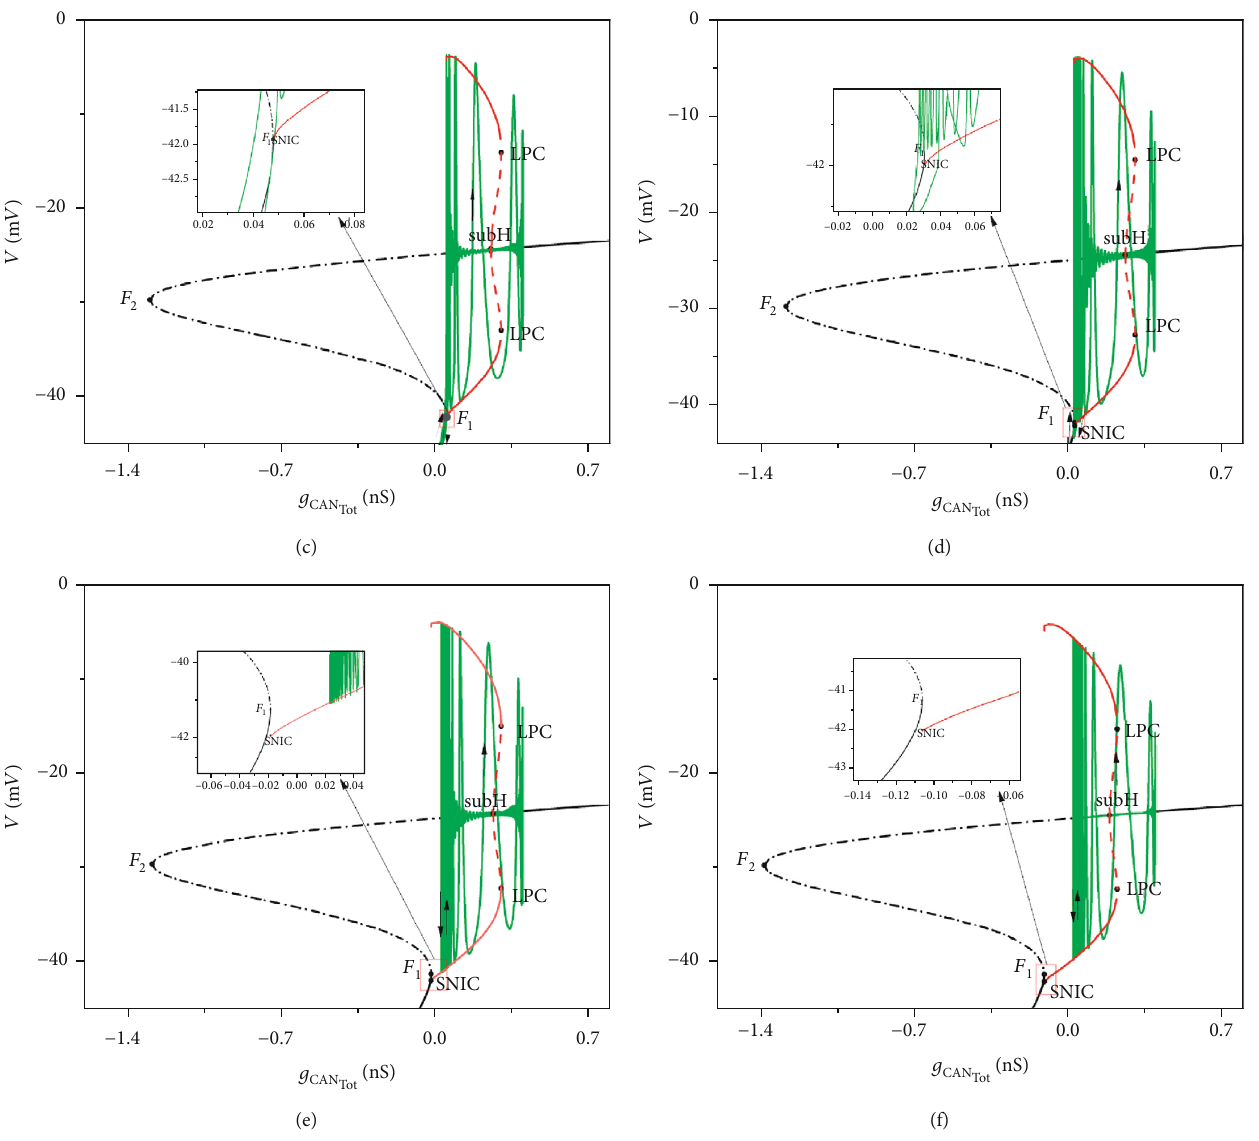
Figure 5: Fast-slow bifurcation analysis of neuronal fi ring patterns under di ff erent electric currents: (a) I = − 2 μ A/cm 2 ; (b) I = 5 μ A/ extz extz cm 2 ; (c) I = 25 μ A/cm 2 ; (d) I = 30 μ A/cm 2 ; (e) I = 40 μ A/cm 2 ; (f) I = 50 μ A/cm 2 . The black solid line represents the stable extz extz extz extz nodes (lower branch) and stable focus (upper branch); the black dash-dot line represents the saddles (middle branch) and the unstable focus (upper branch); the red dashed and solid lines represent the maximum and minimum values of the unstable and stable limit cycles, ð i = 1, 2 Þ and subH represent the fold bifurcation and Hopf bifurcation of equilibrium; the points LPC, HC, and respectively. The points F i SNIC represent the fold bifurcation of the limit cycle, the homoclinic bifurcation, and saddle-node bifurcation on an invariant circle, respectively. The green curve represents the trajectory of the full